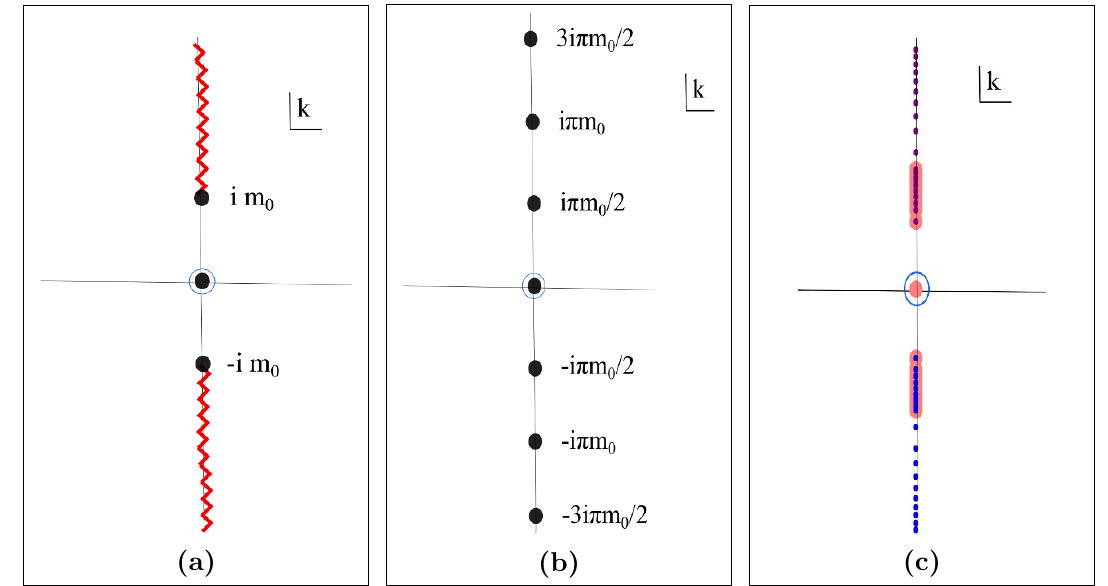
Figure 3 . Singularities governing the two-point function in the complex k -plane: (a) of the quantity G q; 0 ( k ) for the ground state quench propagator (4.11) , (b) of the quantity G (cid:6) ( k ; (cid:12) )